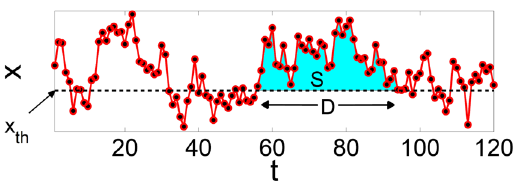
Figure 5. An avalanche is defined as excursion of the aggregate activity of nodes above a threshold value x th , D is the defined as the duration and the integral between x t and x th (the colored area) as the size ( S ) of the avalanche.